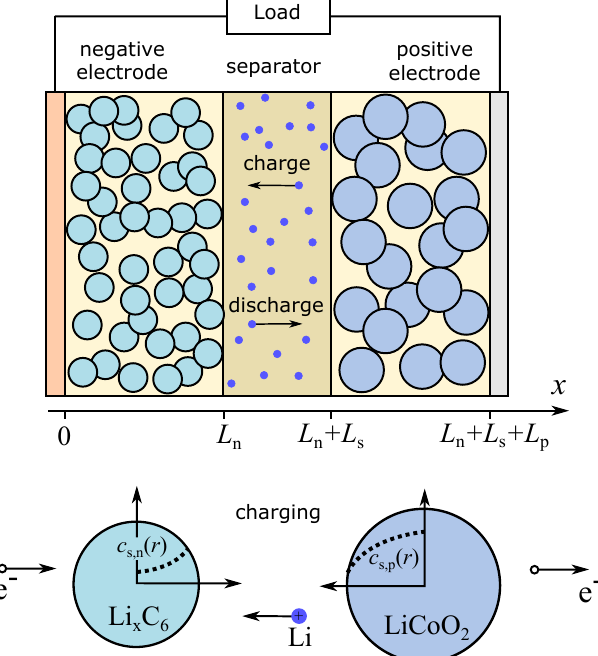
Figure 1. The pseudo-2D model of the Li-ion battery and the single-particle model.